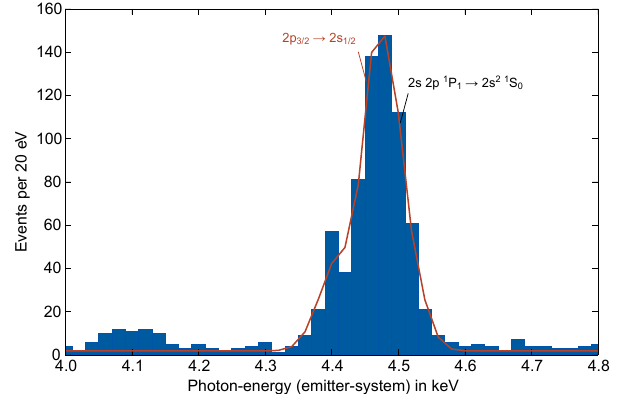
Figure 3. Shown is a spectrum that contains X-ray transitions of U 89 + (red text) and U 88 + (black text) from the N- and M-shells. Furthermore, a fit to a model consisting of all identified lines (red line) is → 2p presented. As an example, for the 3d 3 / 1 / 2 line, the individual fitting result is plotted (yellow, 2 dashed line) in order to illustrate the discussed model function (Equation (1)) that takes into account the different operation points of the detector.